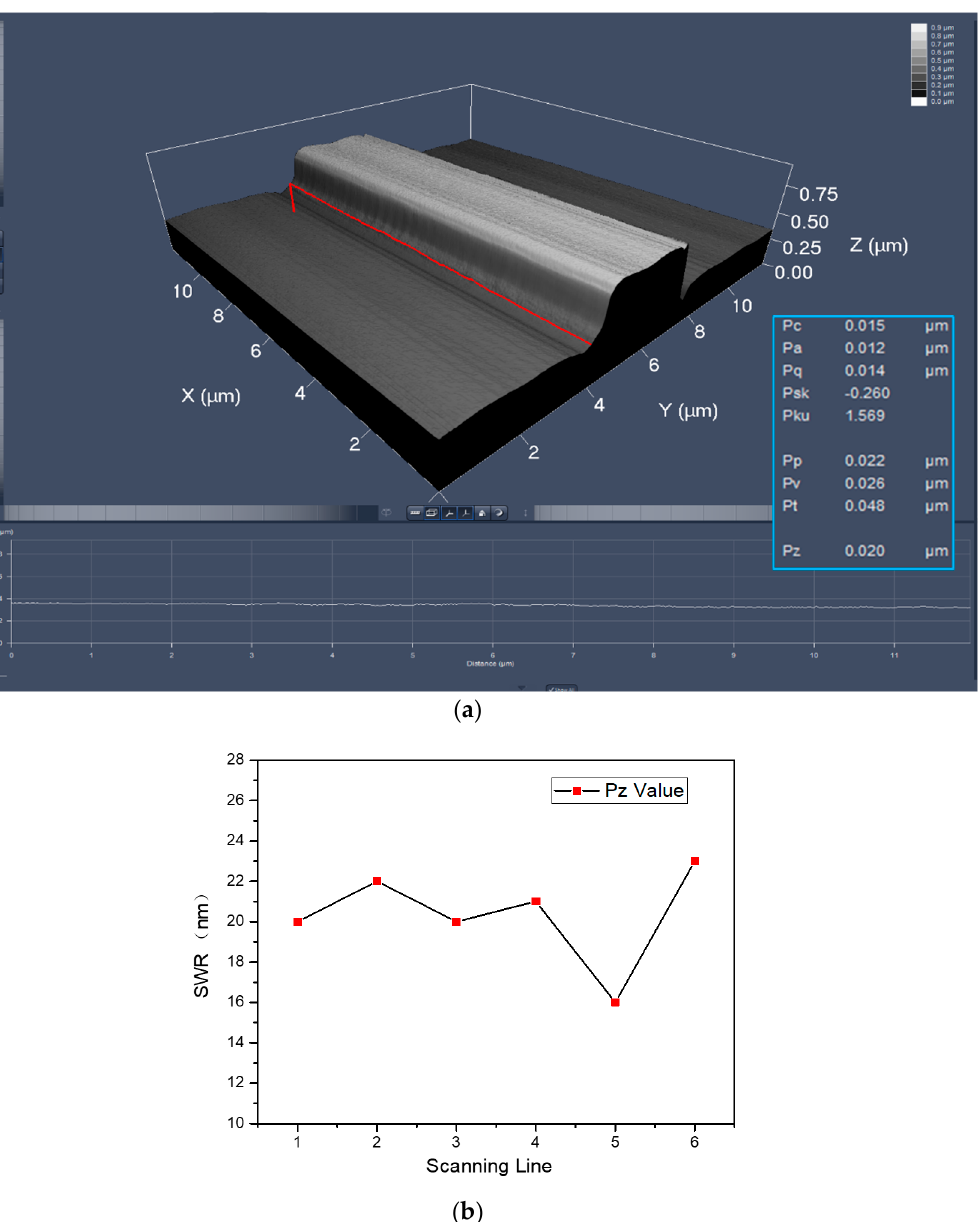
Figure 3. CLSM Measurements and data process of SOI waveguide SWR: ( a ) is the reconstructed image of CLSM measurement, ( b ) is the isotropic roughness distribution of five measured spots.